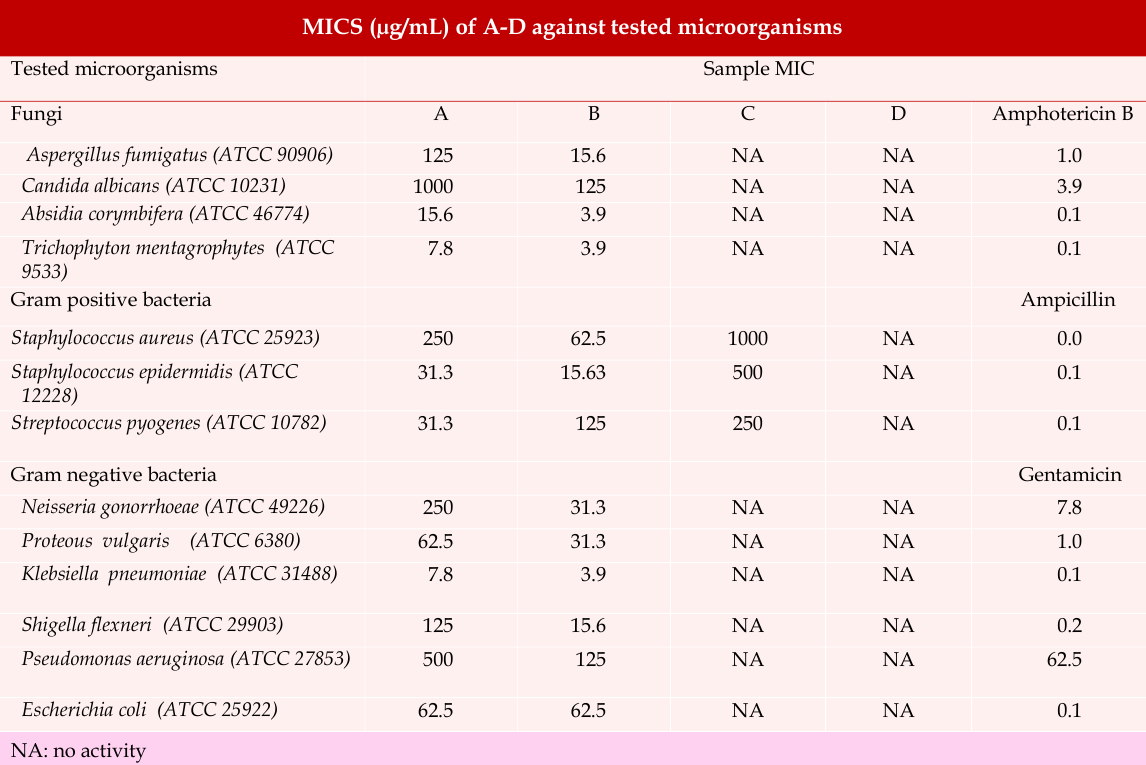
MICS (µg/mL) of A-D against tested